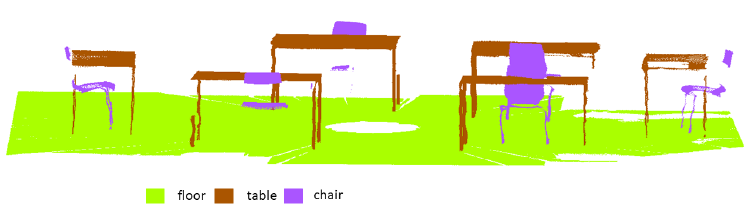
Figure 15. Semantic point cloud consisting of the floor, table and chair classes for visualization of a real